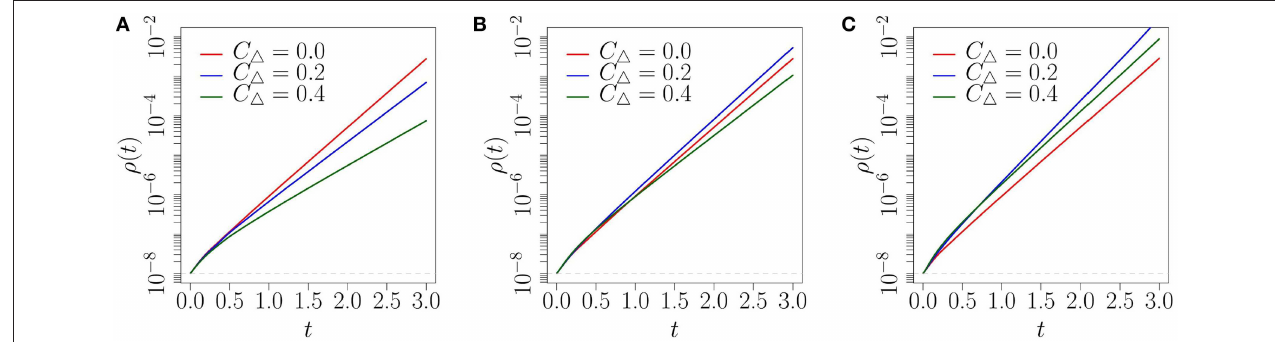
FIGURE 8 | Fraction ρ ( t ) of infected nodes on three network topologies, using the CA scheme: (A) β = 2 ; (B) β = 5 ; (C) β = 10 . Note that the y-axis is logarithmic and ρ 0 10 − 8 . =